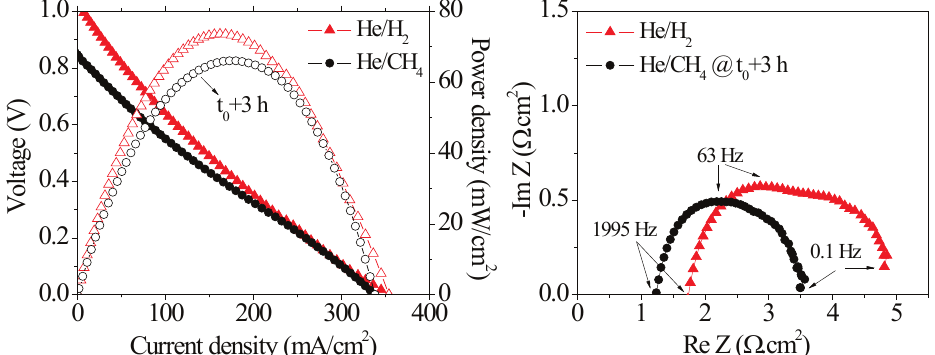
Figure 3. V–I curves and Nyquist plots of impedance spectra for the LSCF-Ni/YSZ anode fuel cell tested at 750 °C in He/H 25 vol% CH ). Impedance spectra were recorded at OCV with frequency range of 10 6 –0.1 Hz. 4 t is the time at which He/H 0